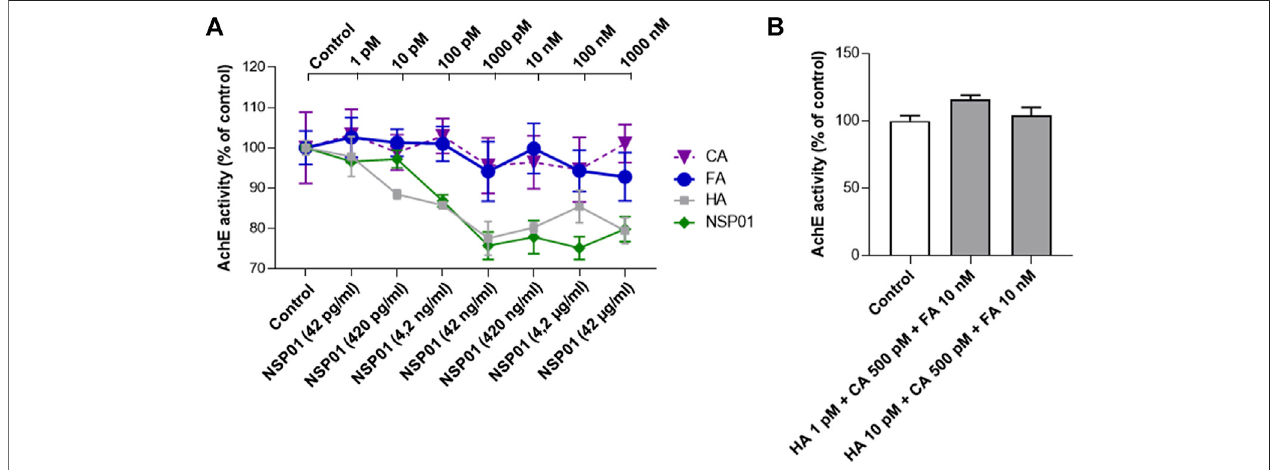
FIGURE 4 | (A) , AChE activity in increasing doses of NSP01 extract and HA, CA and FA. In the abscissae the concentrations of extract tested to determine the inhibitoryeffectonAChE;intheupperpartofthegraphtheconcentrationsofHA,CAandFA.Sixsamples(biologicalreplicates)perconditionwereanalyzed. (B) ,effectof HA/AC/FA mixtures on AChE enzymatic activity. Measurements were done on three biological